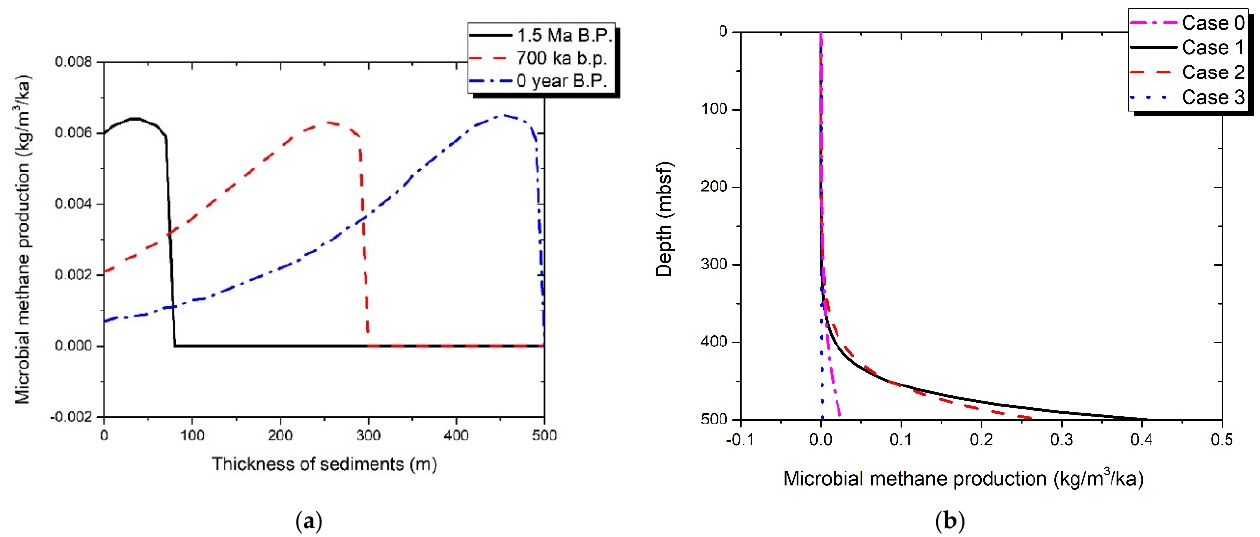
Figure 6. Local microbial methane generation. ( a ) Microbial methane production accompanying deposition in Case 0. ( b ) The final vertical distribution of microbial methane production rate in four designed geological scenarios. Table 1. Four designed geological scenarios for microbial methane generation that may occur in Dongsha area.